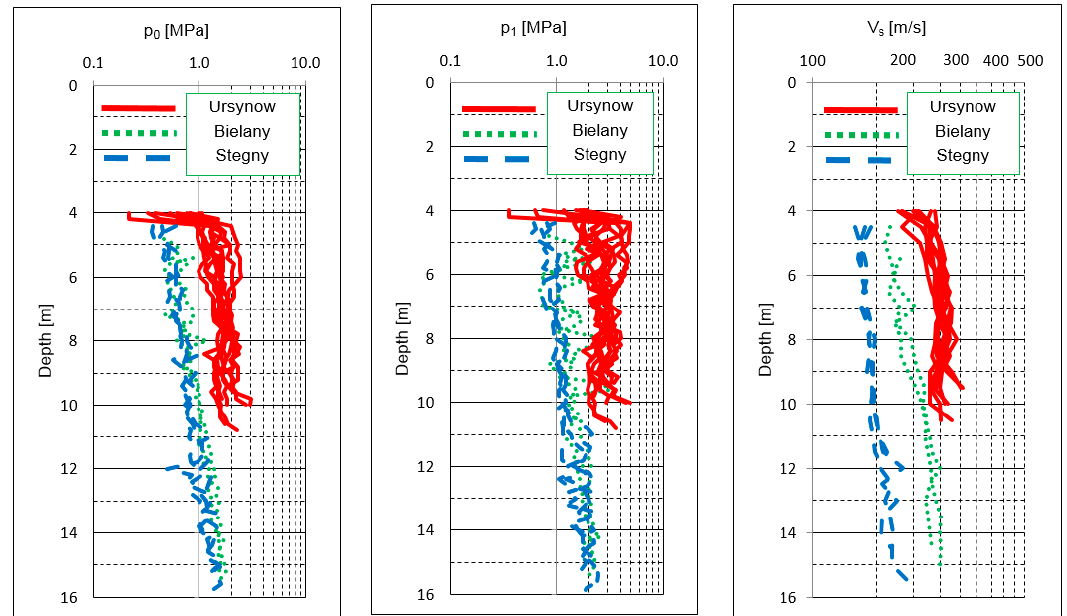
Figure 5. Profiles of the corrected pressure readings p o and p 1 , and shear wave velocity V s from seismic dilatometer tests obtained at the Ursynów, Bielany, and Stegny sites.